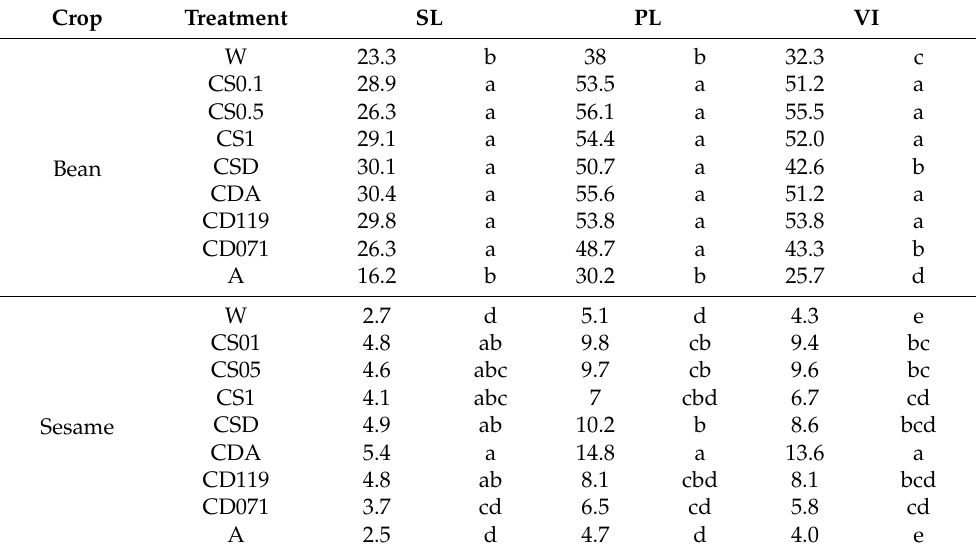
Table 1. Means comparison of stem length, plantlet length and vigor index in bean and sesame plantlets. Crop Treatment SL PL